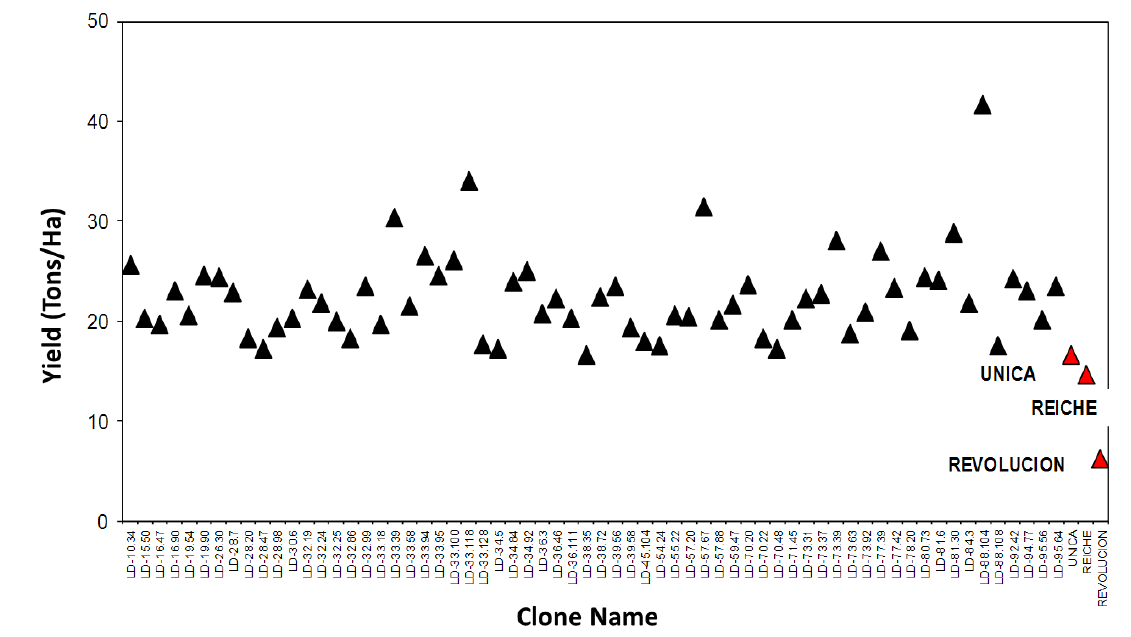
Figure 10: Fresh yield (t/ha) at 70 days after planting new clones (black triangles) of a virus resistant potato population growing in the lowland tropics, and three local varieties (Unica, Reiche, and Revolucion; red triangles with black outlines) (source: M. Bonierbale, pers. comm.)